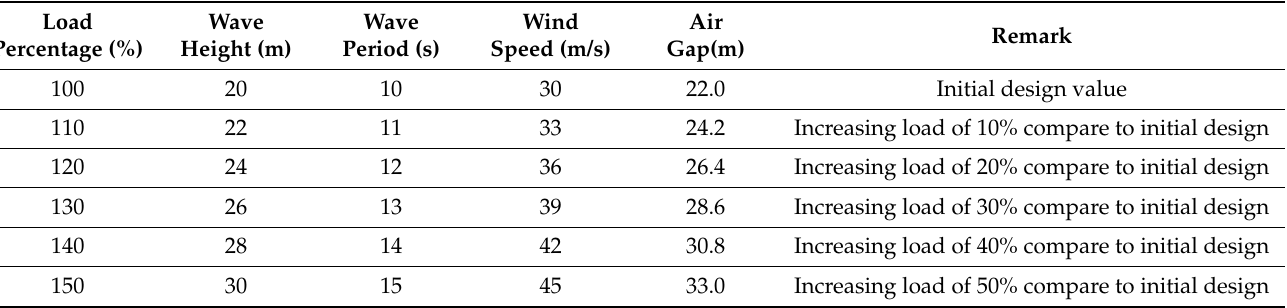
Table 4. Design parameters and load cases.